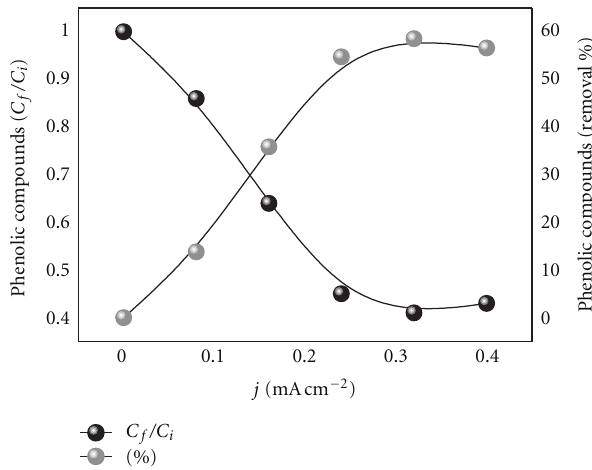
Figure 1: Electro-oxidation of a synthetic solution containing 311 mgL − 1 of phenol in acid solution (pH 1) after the application of di ff erent current densities, using BDD and Ti as anode and cathode, respectively. The results are shown as normalized values (left) and percentages of degradation